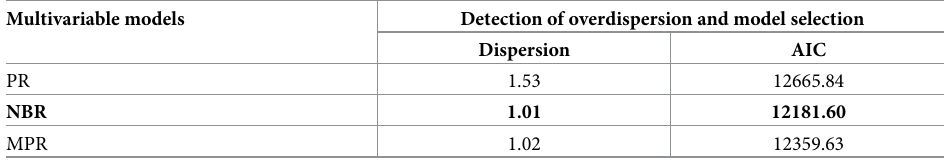
Table 4. Detection of overdispersion and model selection for analyzing pregnancy complications count response data from multivariable Poisson regression (PR), negative binomial regression (NBR) and mixed Poison regres- sion (MPR)